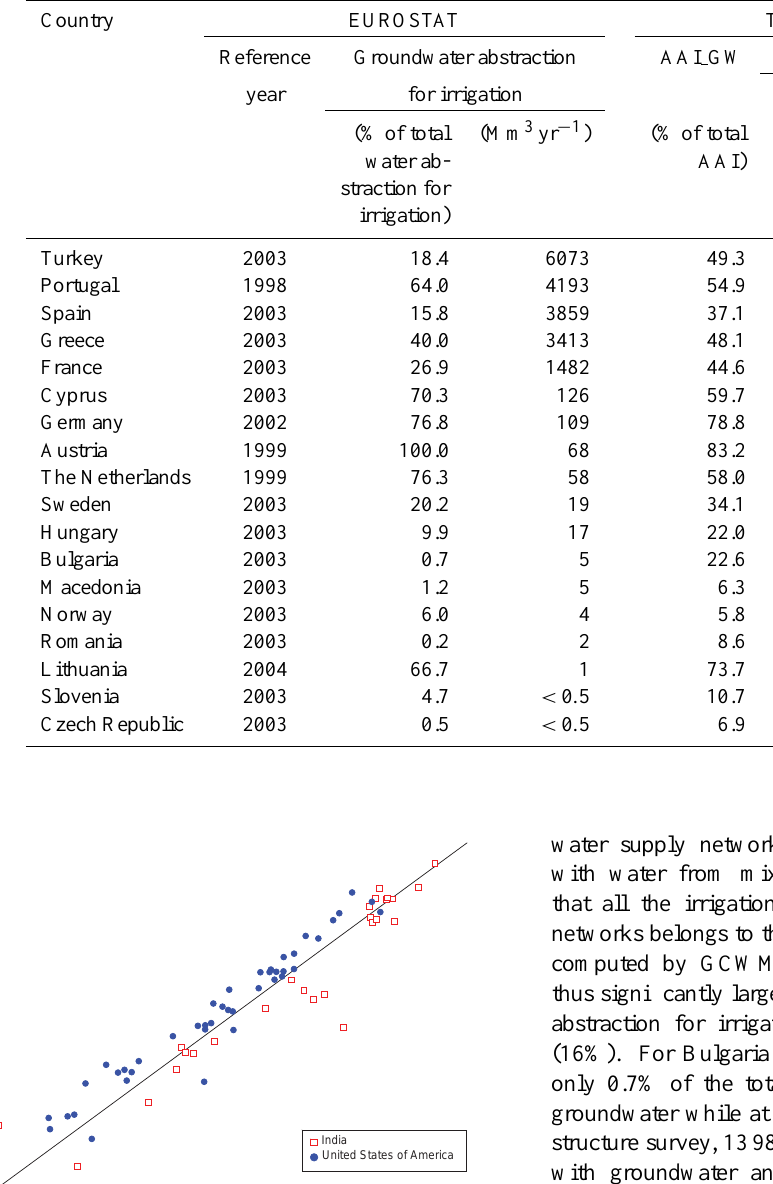
Table 5. Groundwater extraction for irrigation reported for European countries (Eurostat, http://nui.epp.eurostat.ec.europa.eu/nui/show.do? dataset=env watq2 1&lang=en, last access: 9 April 2010), area actually irrigated with groundwater (AAI GW) and consumptive groundwater use for irrigation (ICWU GW) as computed in this manuscript.